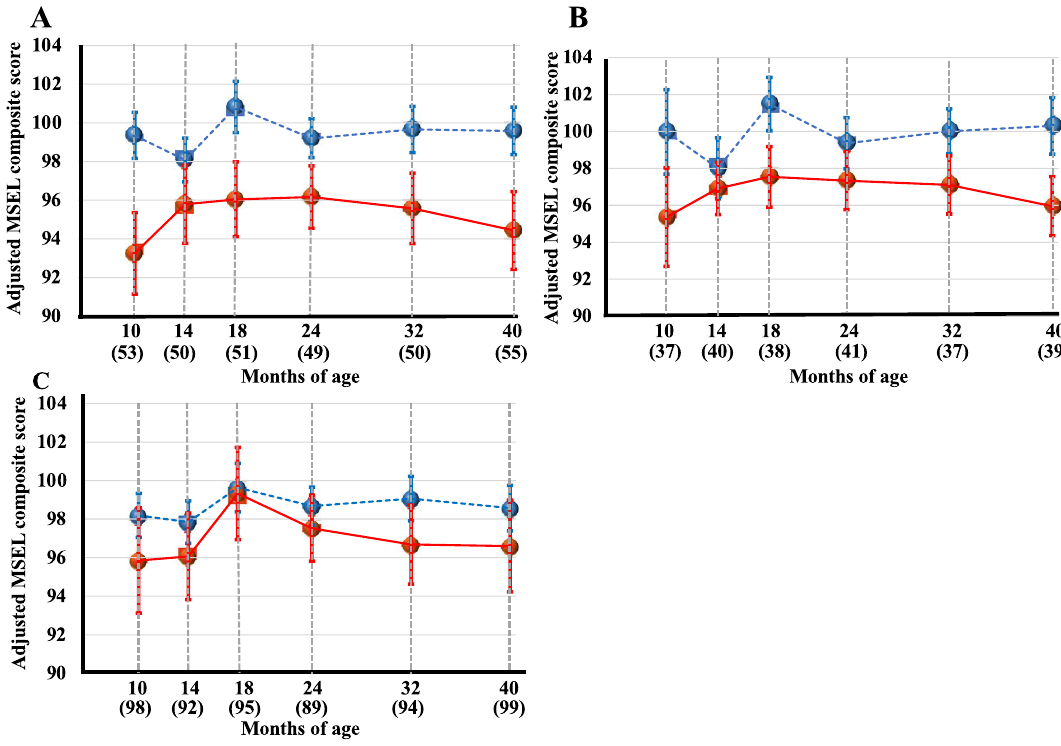
Figure 2. Chronological changes of Mullen Scales of Early Learning composite scores in each placental pathological finding during 10 to 40 months; ‘Accelerated villous maturation’ ( A ), ‘Delayed villous maturation’ ( B ), and ‘Maternal vascular malperfusion’ ( C ) as significant predictors of the relatively lower MSEL composite scores in the infantile neurodevelopmental milestones by a mixed model analysis. Red and blue dots indicate MSEL composite scores with and without ‘Accelerated villous maturation’, ‘Maternal vascular malperfusion’, or ‘Delayed villous maturation’, respectively. Circles and error bars indicate the mean and the standard error of the